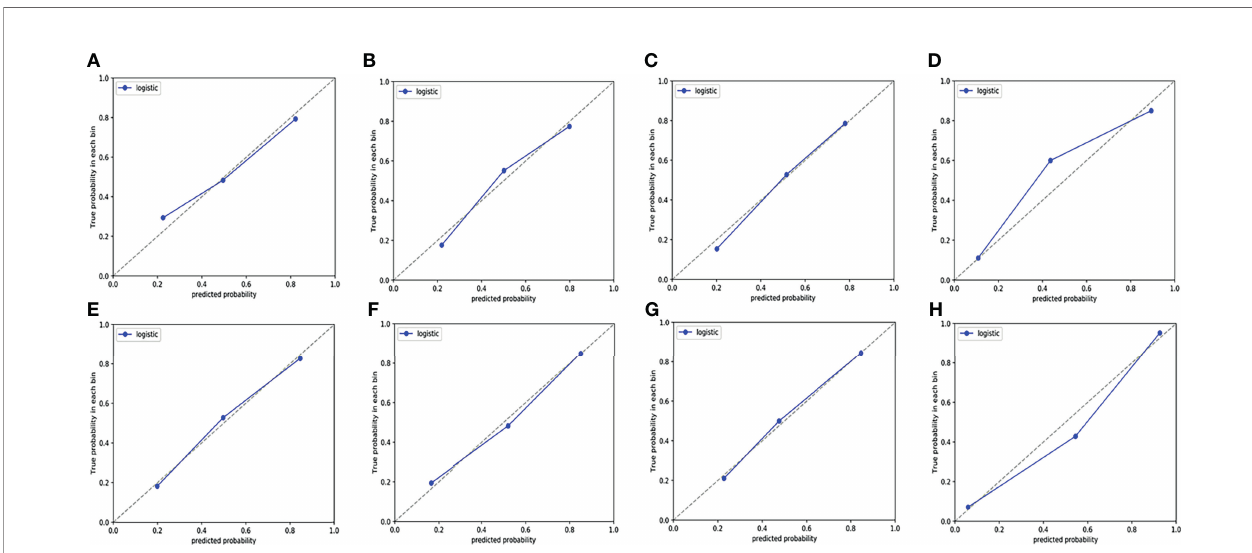
FIGURE 5 | Calibration curves of the prediction model in training cohort. (A – D) Calibration curves for a model that predicts the expression level of Ki-67. (A) T 2 WI. (B) DWI. (C) CE-T 1 WI. (D) ADC value combined with T 2 WI + DWI + CE-T 1 WI. (E – H) Calibration curves for a model that predicts the expression level of p53. (E) T 2 WI. (F) DWI. (G)